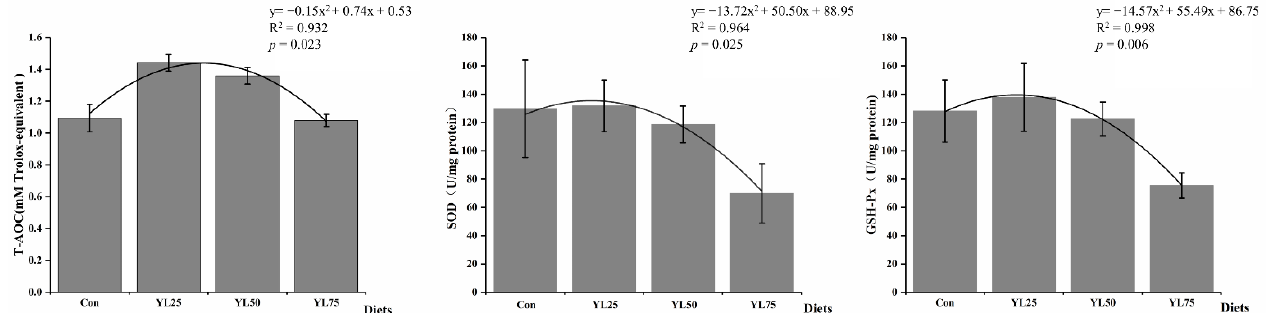
Figure 1. Effects of dietary YL on antioxidant-related enzyme activities of intestine in juvenile large- mouth bass. T-AOC, total antioxidant capacity; SOD, superoxide dismutase; GSH-Px, glutathione